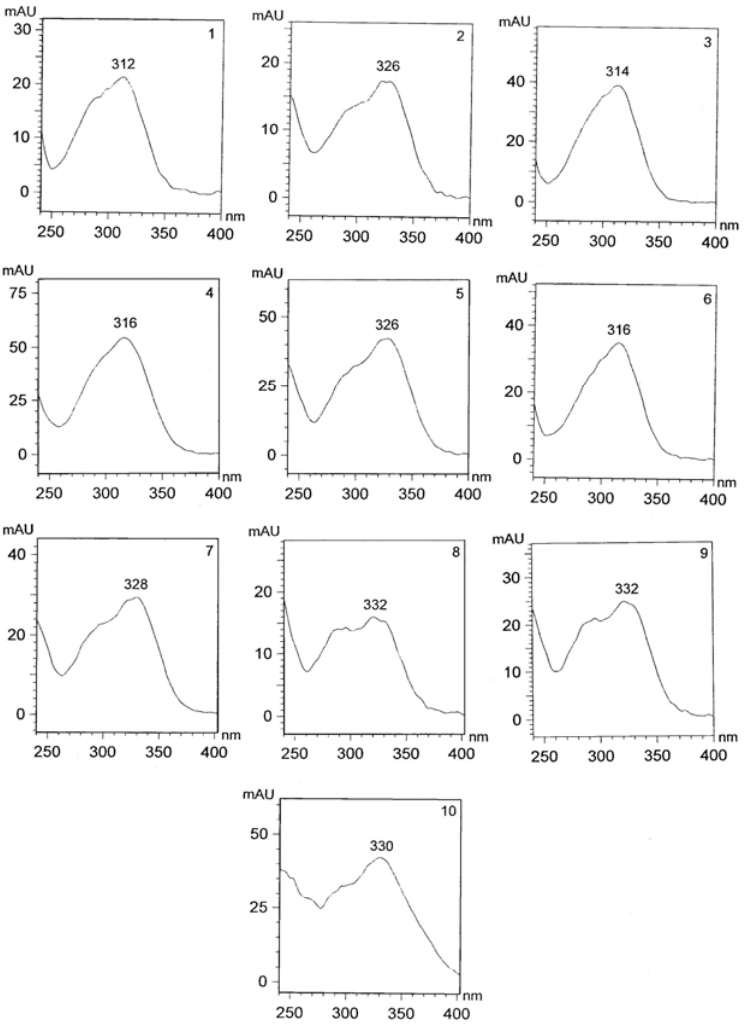
Figure 2. UV-DAD spectra of individual phenolic compounds (numbers of compounds are the same as numbers of peaks mentioned in Figure 1) of extracts of the seeds of White star cowpea cultivar.